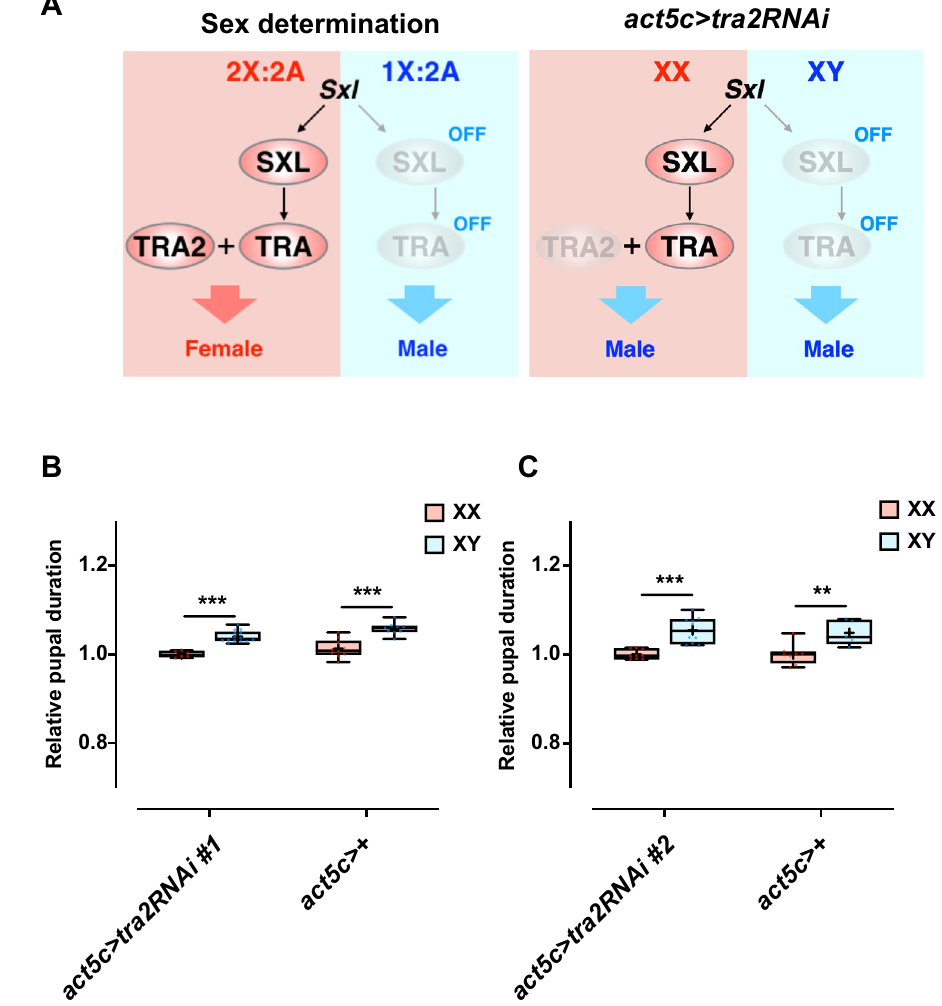
Figure 2. RNA interference-mediated knockdown of tra-2 does not affect the protogyny phenotype. ( A ) Schematic presentation of the sex-determination pathway and the effect of altering tra-2 expression. ( B , C ) Effect of act5c > tra2 RNAi #1 ( B ) and act5c > tra2 RNAi #2 ( C ) on the protogyny phenotype. Whiskers indicate minimum and maximum values (*** p < 0.001, ** p < 0.01 by Student’s unpaired t